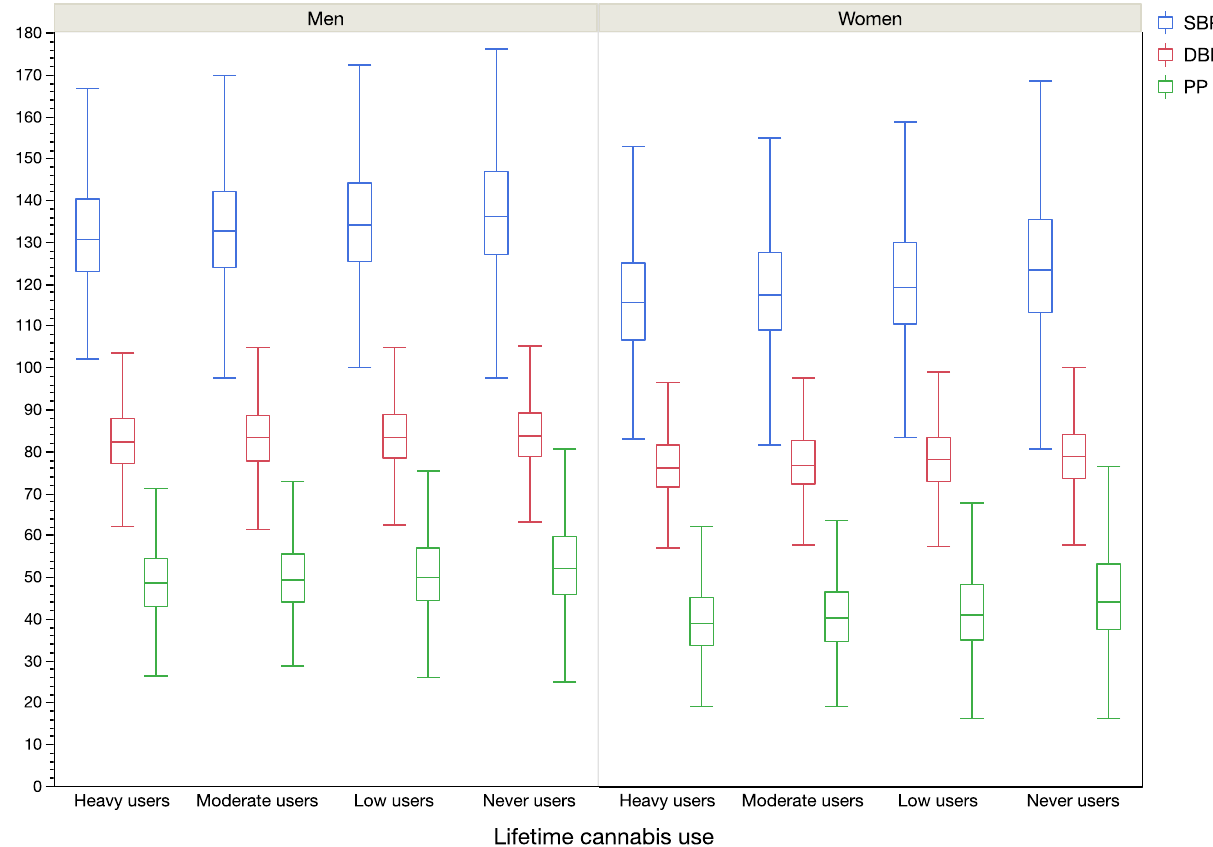
Figure 2. Blood pressure parameters (SBP, DBP and PP) according to gender and cannabis use groups (p < 0.001 in all